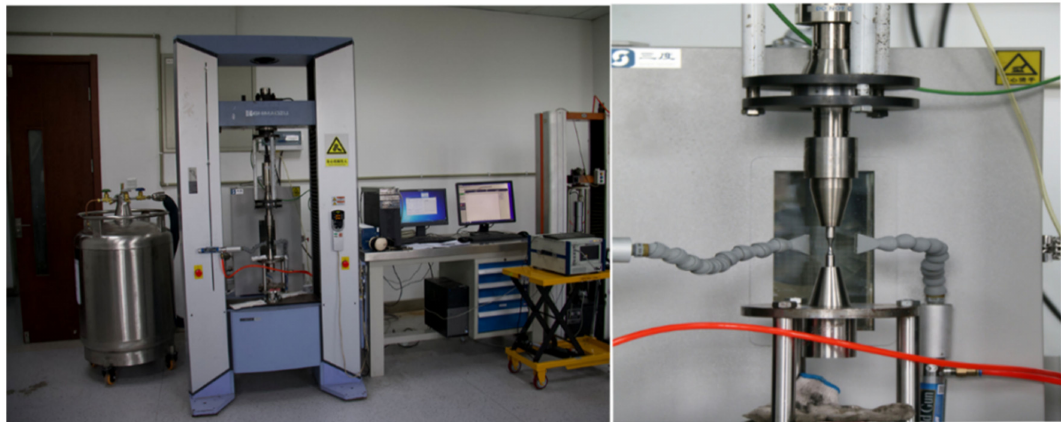
Figure 3. Ultrasonic fatigue testing machine [31].